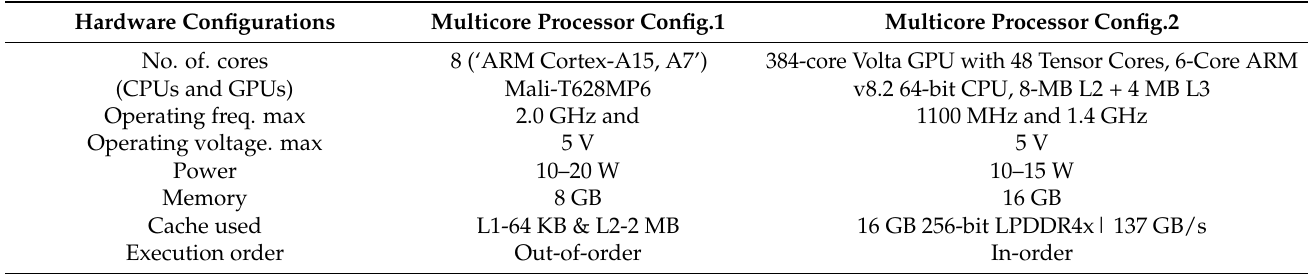
Table 4. Hardware Configuration Details.